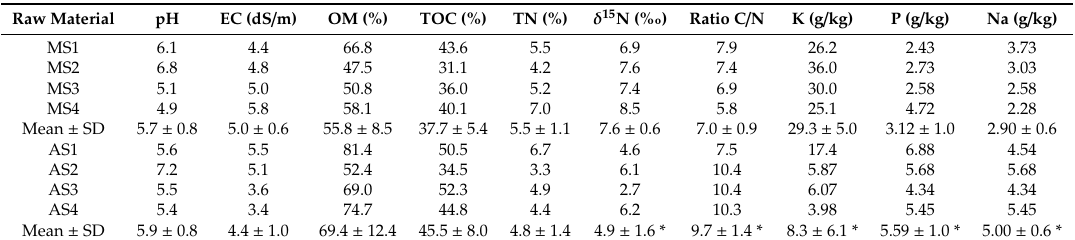
Table 2. Main physico-chemical and chemical characteristics of the raw materials used in the composting mixtures (data on a dry weight